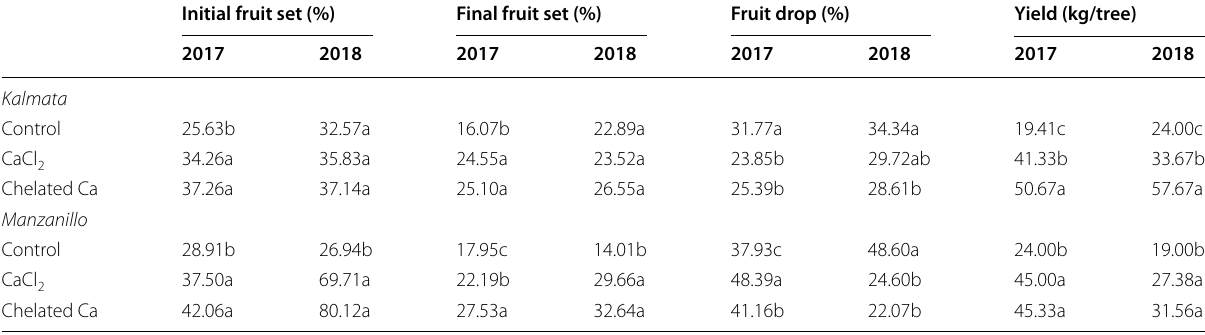
Table 2 Effect of foliar spray with some calcium sources on fruit set and yield of olive Kalmata and Manzanillo cultivars Initial fruit set (%) Final fruit set (%) Fruit drop (%) Yield